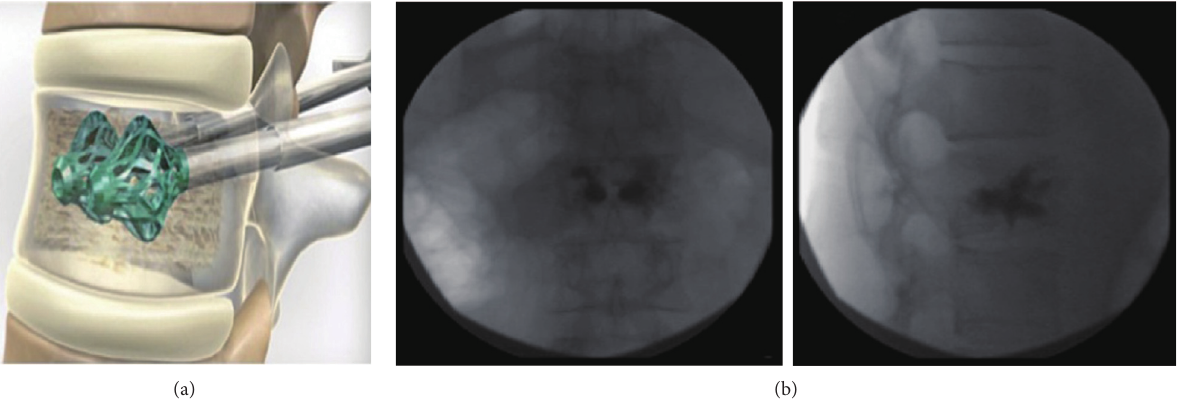
Figure 3: (a) OsseoFix ® System. (b) Osteoporotic vertebral fracture lateral fluoroscopy view